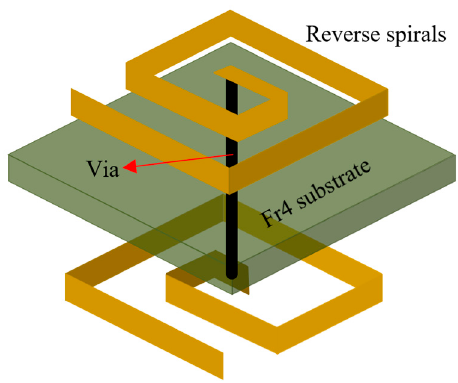
Figure 1. The Swiss roll structure of the metamaterial (MTM) unit. Two reverse spirals on each side of Fr4 substrate.